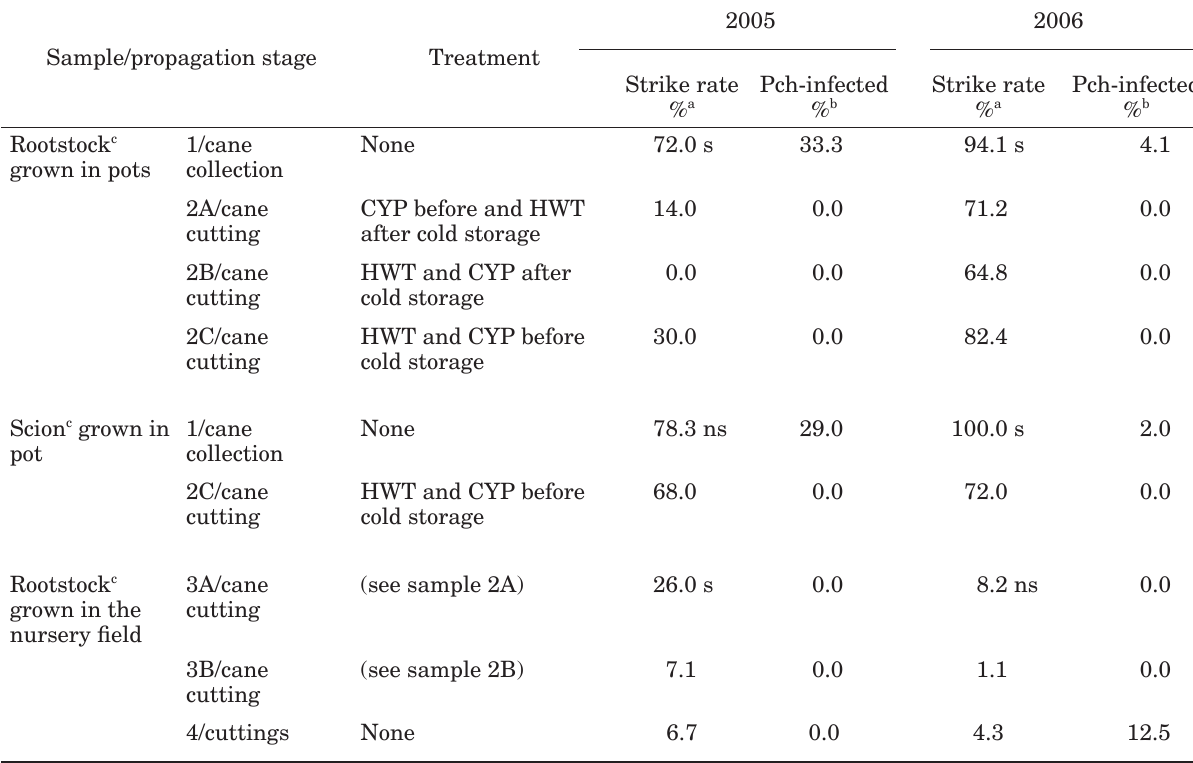
Table 3. Influence of hot water treatment (HWT) and cyproconazole (CYP) on the strike rate of rootstock and scion cuttings grown in different conditions and on Phaeomoniella chlamydospora (Pch) in 2005 and 2006.